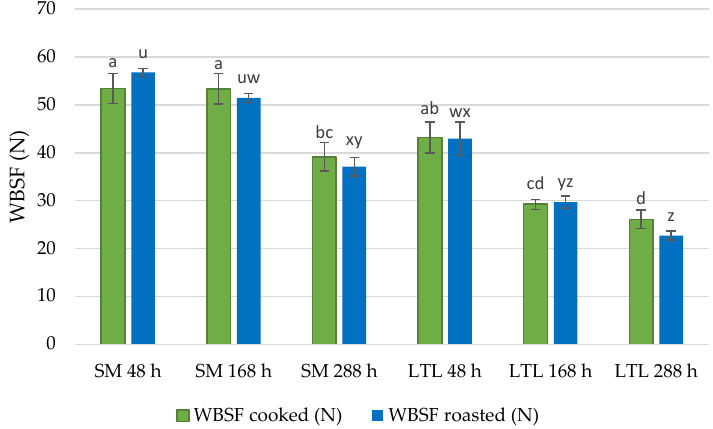
Figure 3. Warner–Bratzler shear force (WBSF) in cooked and roasted semimembranosus (SM) and longissimus thoracis et lumborum (LTL) muscles aged for 48 h, 168 h, and 288 h (a–d—mean values with different letters differ significantly at p < 0.05 in cooked muscles; u–z—mean values with different letters differ significantly at p < 0.05 in roasted muscles; vertical bars refer to the standard error of the mean). Table 3. The effect of muscle, ageing and thermal treatment method on cooking loss, volume loss, and Warmer–Bratzler Shear Force (WBSF) in fallow deer meat (mean values and standard error of the mean in brackets).